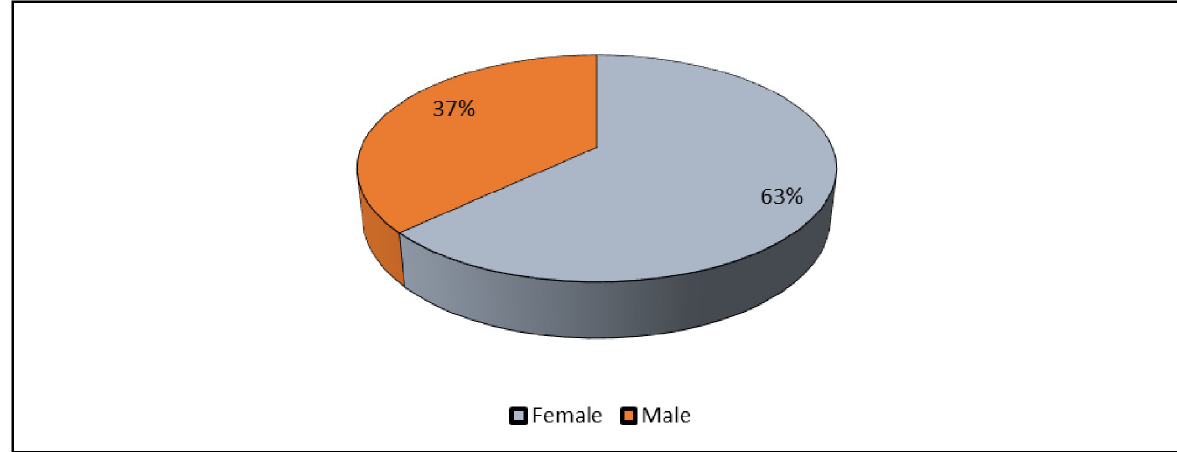
Fig 3. Participants’